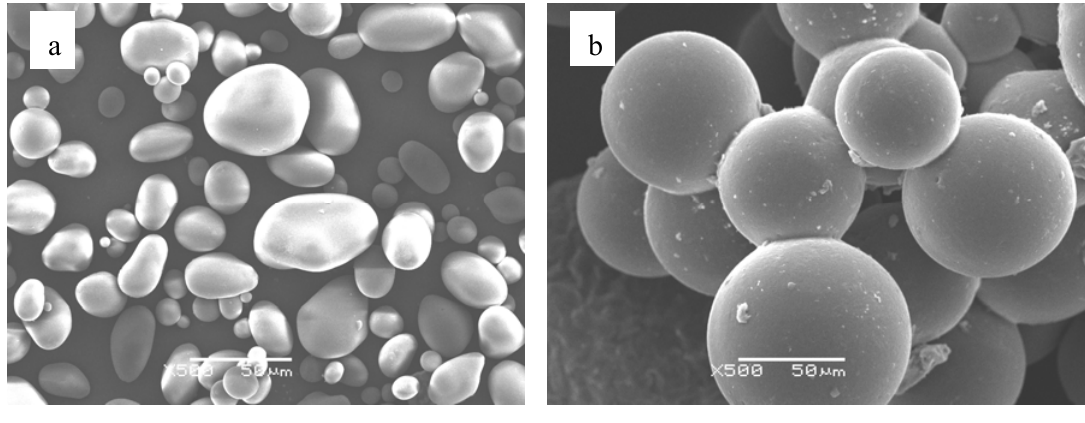
Figure 1. Scanning electron micrograph (SEM) of (a) soluble starch; (b)